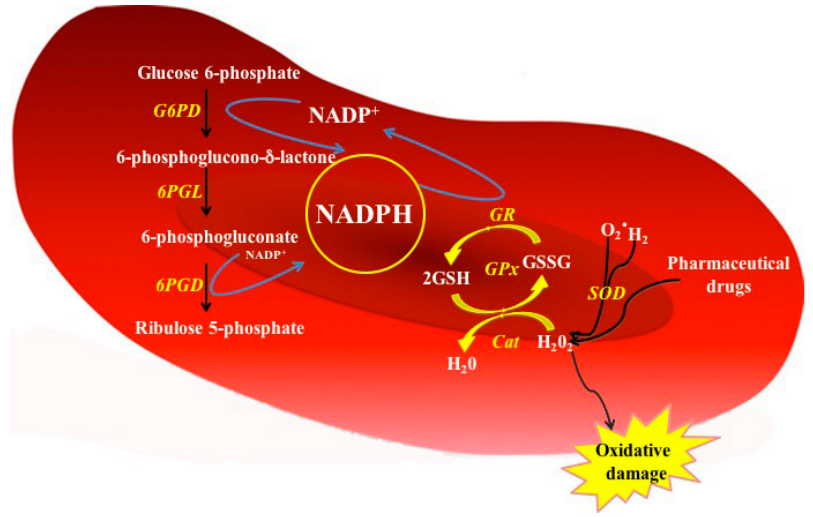
Figure 3. Function of G6PD enzyme in the PPP from red blood cells. In G6PD-normal red cells, the NADPH is produced by the action of glucose 6-phosphate dehydrogenase (G6PD) and 6-phosphogluconate dehydrogenase (6PGD) enzymes. The NADPH serves as proton donor to regenerates the GSSG oxidized. Cat = Catalase; GPx = Glutathione peroxidase; GR = Glutathione reductase; G6PD = glucose 6-phosphate dehydrogenase; 6PGL = 6-phosphogluconolactonase; 6GPD = 6-phosphogluconate dehydrogenase; SOD = Superoxide dismutase; GSH = Reduced glutathione; GSSG = Oxidized glutathione; H 2 O 2 = Peroxide; O 2 − = Superoxide.